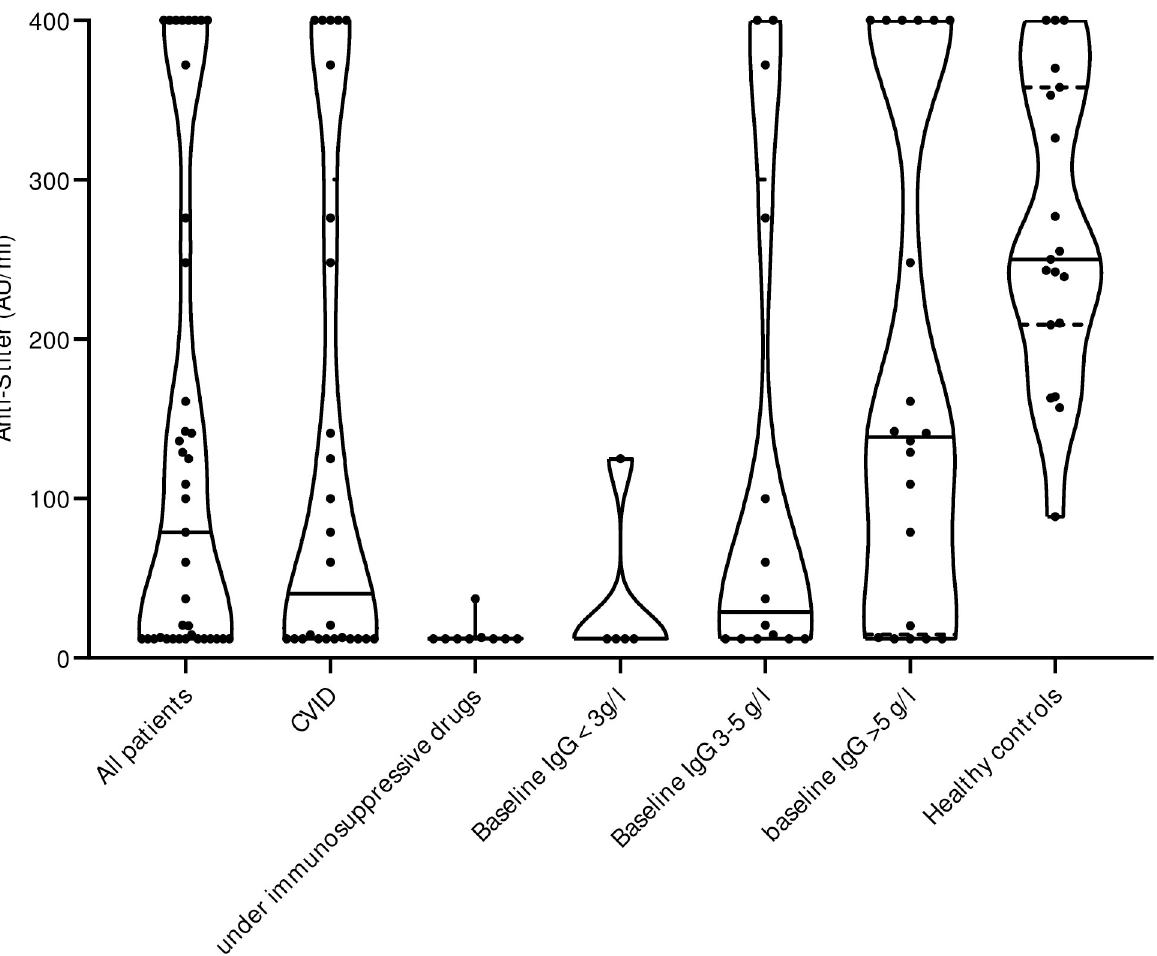
Fig 2. Anti-S quantity subgroup analysis. All included patients were divided into subgroups according to baseline total IgG levels at start of immunoglobulin replacement therapy. Kruskal-Wallis test was calculated for the comparison of the IgG subgroups and healthy control: p = 0.002. Anti-SARS-CoV-2 spike protein antibodies